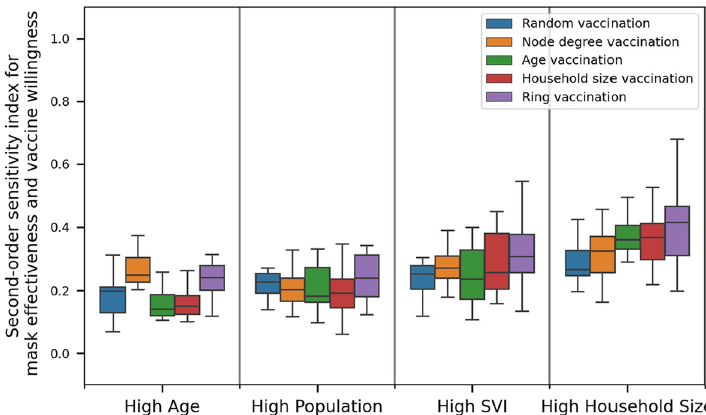
Fig. 14 Distribution of second-order sensitivity on peak hospitalizations. Results are grouped by community and vaccine prioritization. Each box includes the 25th, 50th and 75th percentile for the model output, with whiskers that extend to 1.5 times the interquartile